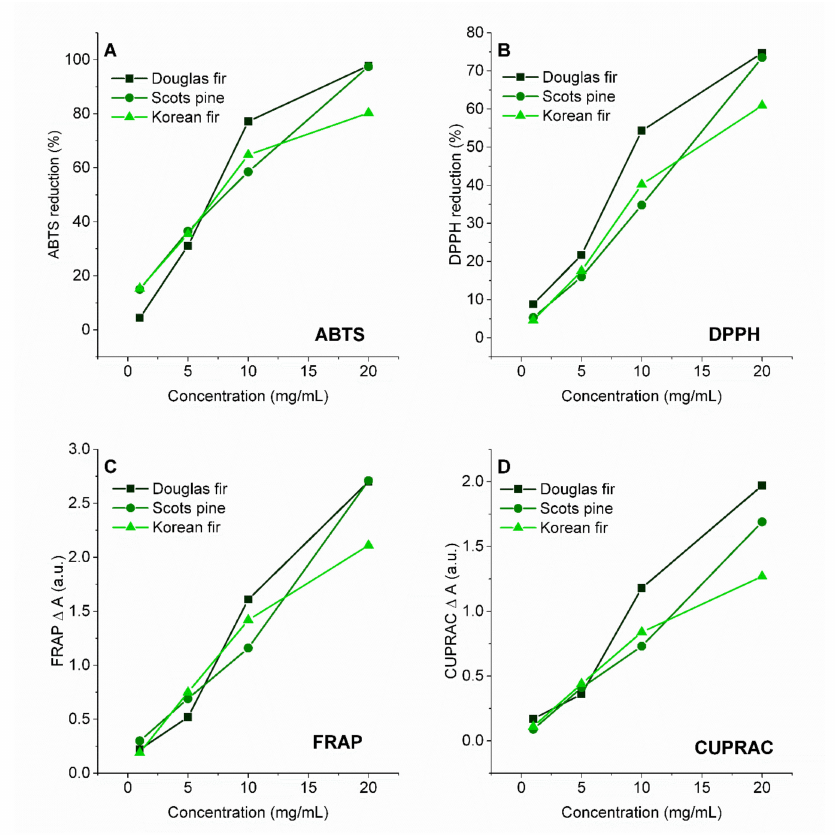
Figure 4. ( A ) Reduction of free radicals ABTS and ( B ) DPPH; ( C ) ability to reduce iron ions FRAP and ( D ) copper ions CUPRAC measured for cone extracts of Douglas fir, Scots pine and Korean